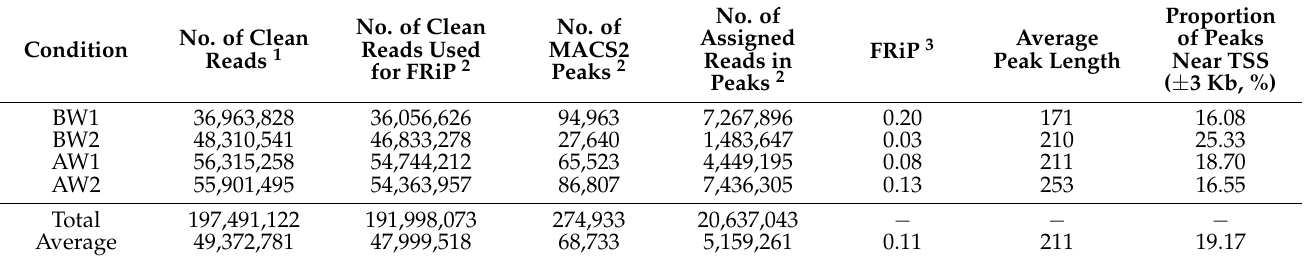
Table 2. Peak calling metrics showing the total number of clean reads used to call peaks and calculate the fraction of reads in peaks (FRiP), MACS2 peaks (FDR < 0.05), assigned reads in peaks, FRiP, average of peak lengths, and proportion of peaks near the TSS ( ± 3 Kb,